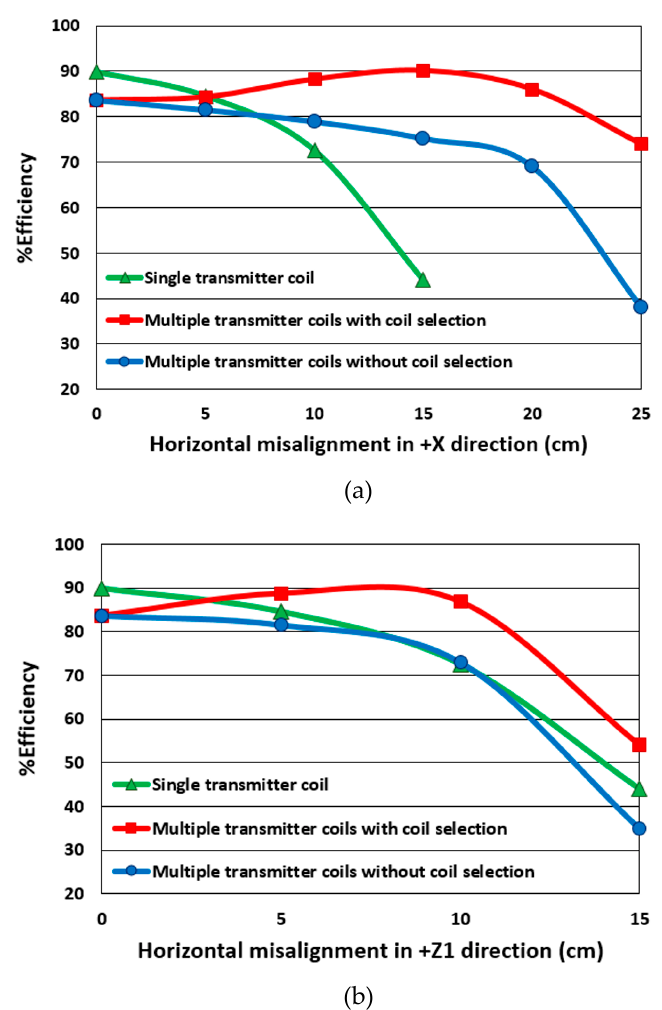
Figure 21. Measured system e ffi ciency: ( a ) Receiver coil movement along the + X direction; ( b ) Receiver coil movement along the + Z1